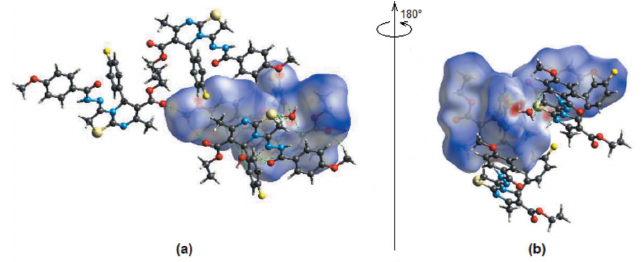
Figure 5 ( a ) Front and ( b ) back sides of the three-dimensional Hirshfeld surface of the title compound mapped over d norm , with a fixed colour scale of (cid:5) 0.7253 (red) to +1.4745 (blue) a.u.